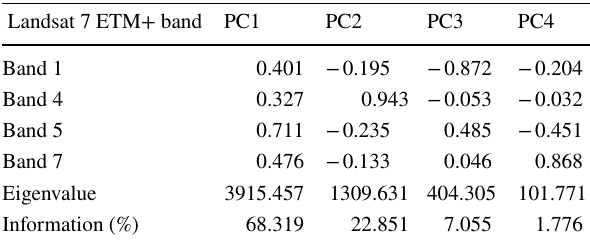
Fig. 4 PC image 1457PC3 showing ferric iron (Fe 3+ ) mineral-rich areas as high pixel and ferric iron mineral-poor (bleaching of red beds) areas as low pixel values Table 1 Eigenvector and eigenvalues of PCA on bands 1, 4, 5 and 7 Landsat 7 ETM+ band